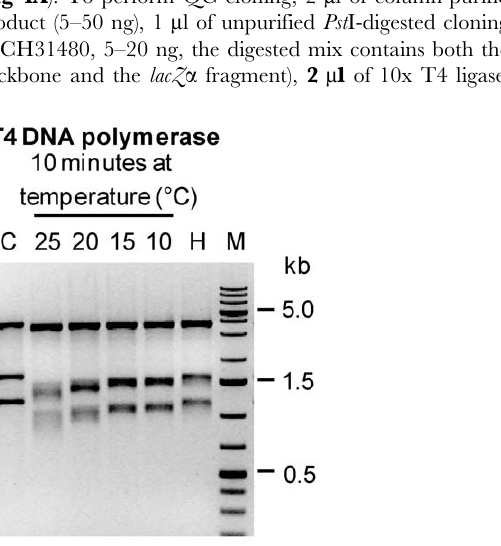
Figure 2. Quantification of T4 DNA polymerase exonuclease activity. Sac II/ Nde I-digested plasmid DNA (3 fragments, lane C) was treated with T4 DNA polymerase for 10 minutes at 25 u C, 20 u C, 15 u C and 10 u C. The T4 DNA polymerase was then inactivated by incubation at 80 u C for 5 min. The single-stranded ends generated by the 3 9 to 5 9 exonuclease activity T4 DNA polymerase were removed by using Mung Bean nuclease. The size of the resulting fragments was analyzed by agarose gel electrophoresis. As a control for the heat inactivation of T4 DNA polymerase, digested plasmid DNA was inactivated at 80 u C for 5 minutes immediately after addition of T4 DNA polymerase (lane H).